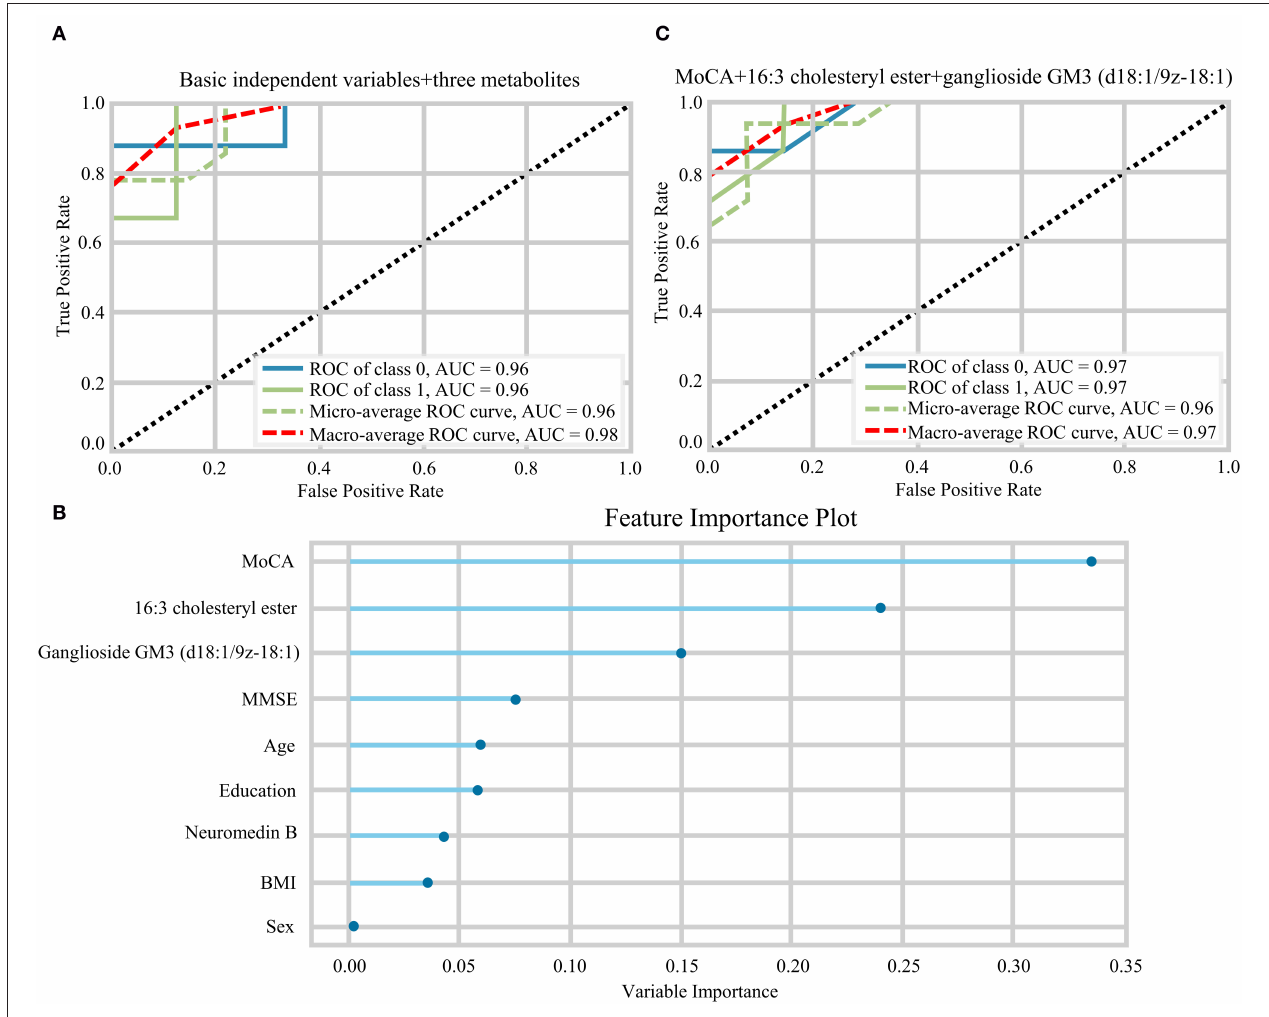
FIGURE 6 | (A) The ROC curves of all independent variables. (B) Feature importance ranking of prediction model with all independent variables. (C) The ROC curves of MoCA + 16:3 cholesteryl ester + 16:3 cholesteryl ester. between serum neuromedin B levels and MCI or AD